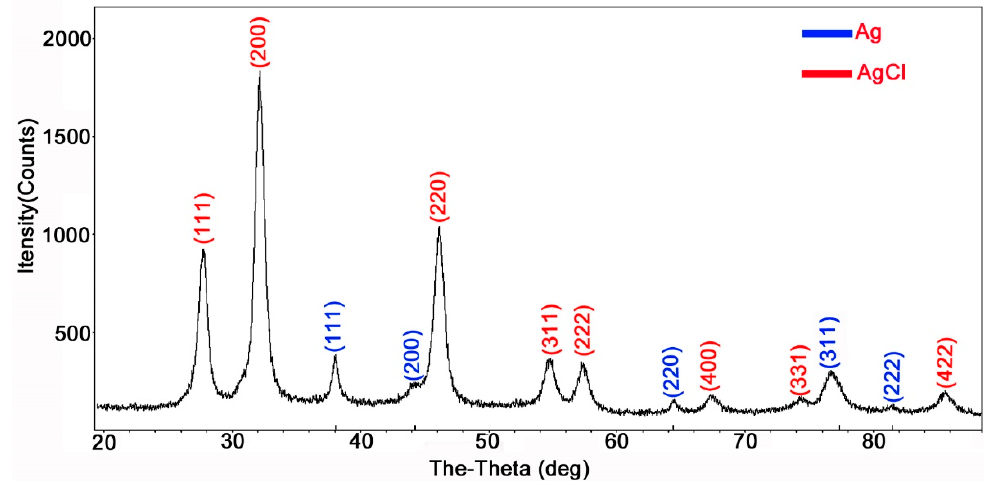
Figure 3. X-ray diffraction patterns of the biosynthesized AgCl-NPs by CFCS extract of bacterium strain IMA13.